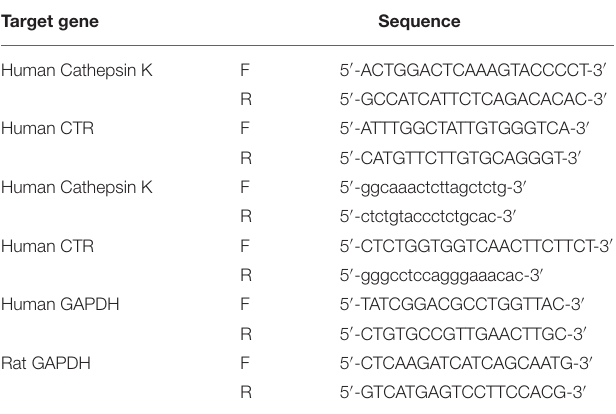
TABLE 1 | The primers list in qPCR